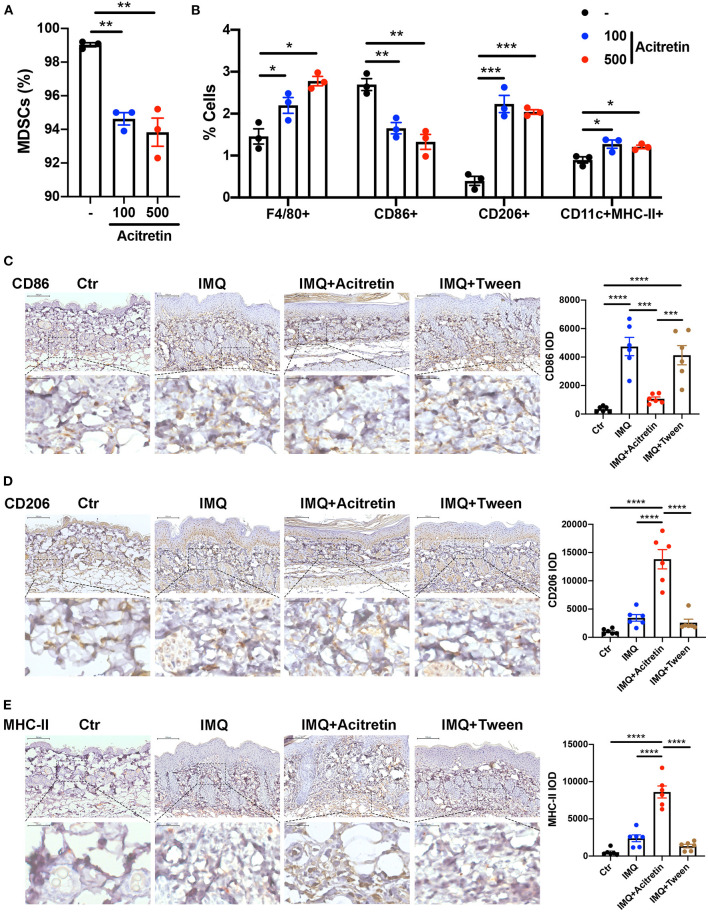
Acitretin promoted the differentiation of MDSCs. (A,B) MDSCs were isolated from the bone marrow of IMQ-induced model mice and cultured for 4 days with 20 ng/mL GM-CSF. Acitretin (100 ng/mL or 500 ng/mL) or vehicle control (-) was added on days 1 and 3. (A) The percentages of MDSCs treated with acitretin. (B) The effect of acitretin on differentiation of MDSCs into F4/80+ macrophage, CD86+ M1 macrophage, CD206+ M2 macrophage, and CD11c+MHC II+ dendritic cells. The presence of different cell populations was evaluated by flow cytometry. (C–E) IMQ-induced psoriasis-like model mice treated with oral acitretin or tween (solvent) once per day for 6 days. Paraffin sections of the back skin of Control (Ctr), IMQ, IMQ+Acitretin, and IMQ+Tween group were stained for CD86, CD206, and MHC-II by immunohistochemistry. CD86 IOD, CD206 IOD, and MHC-II IOD measured by image pro plus 6.0 expressed the CD86, CD206, and MHC-II expression. (C) CD86 stain, (D) CD206 stain, (E) MHC-II stain. Scale bars: 100 μm (upper panel), scale bars: 20 μm (lower panel). Statistical data are shown in the right panel. All results represent at least three independent experiments. Data represent the mean ± SEM. *p < 0.05, **p < 0.01, ***p < 0.001, ****p < 0.0001.